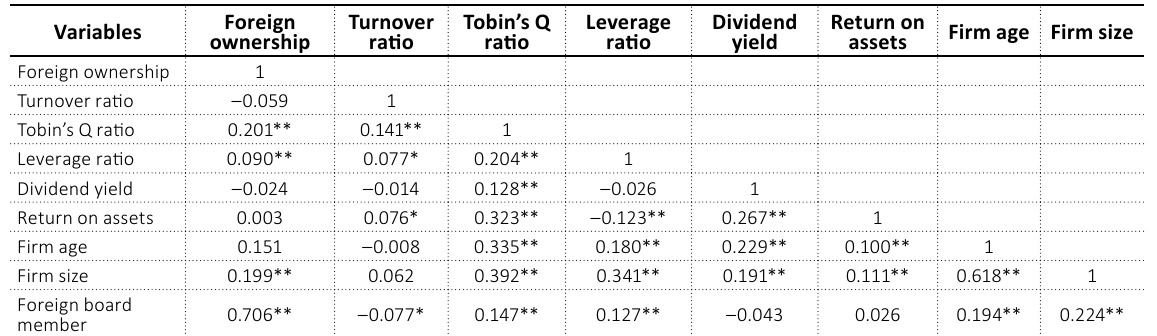
Table 3. Correlation